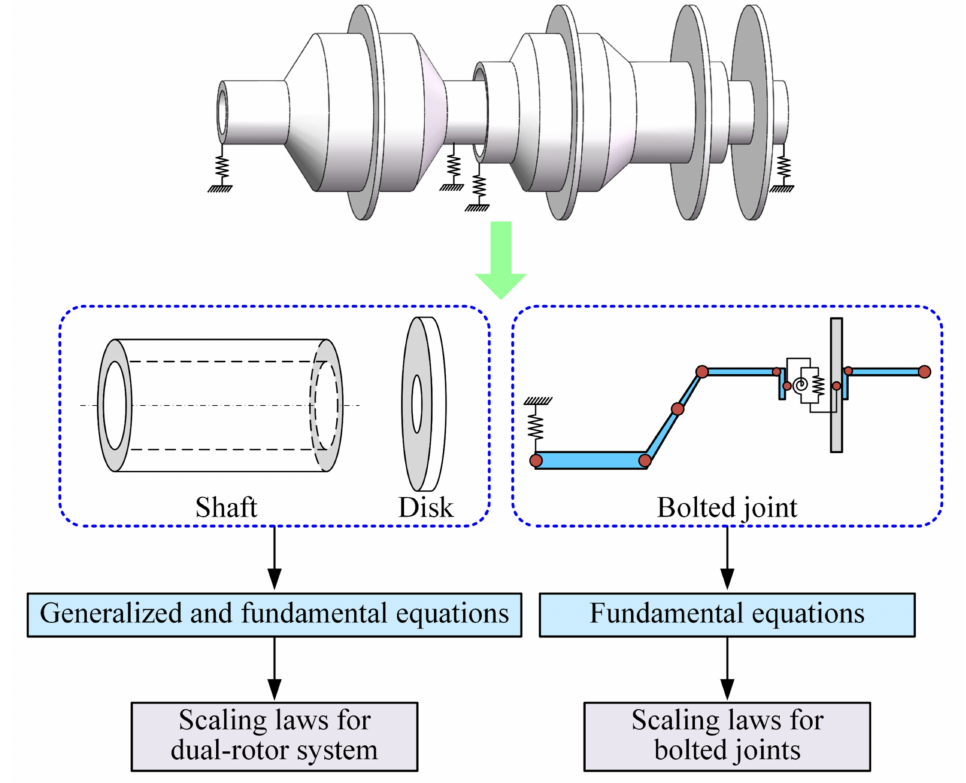
Figure 9. Schematic diagram of deriving scaling